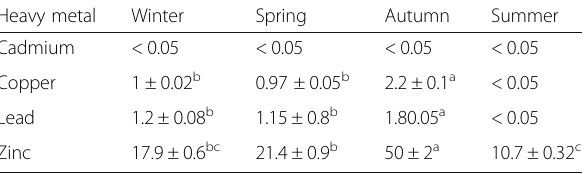
Table 3 Seasonal variations of heavy metals concentrations ( μ g/ g dry weight) in muscle tissue of Oreochromis niloticus Heavy metal